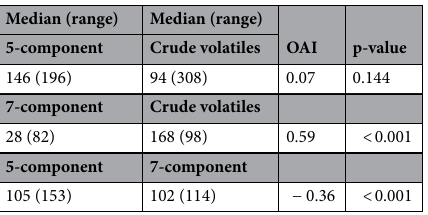
Table 3. Binary comparison of oviposition response of blends at optimal attractive doses and crude